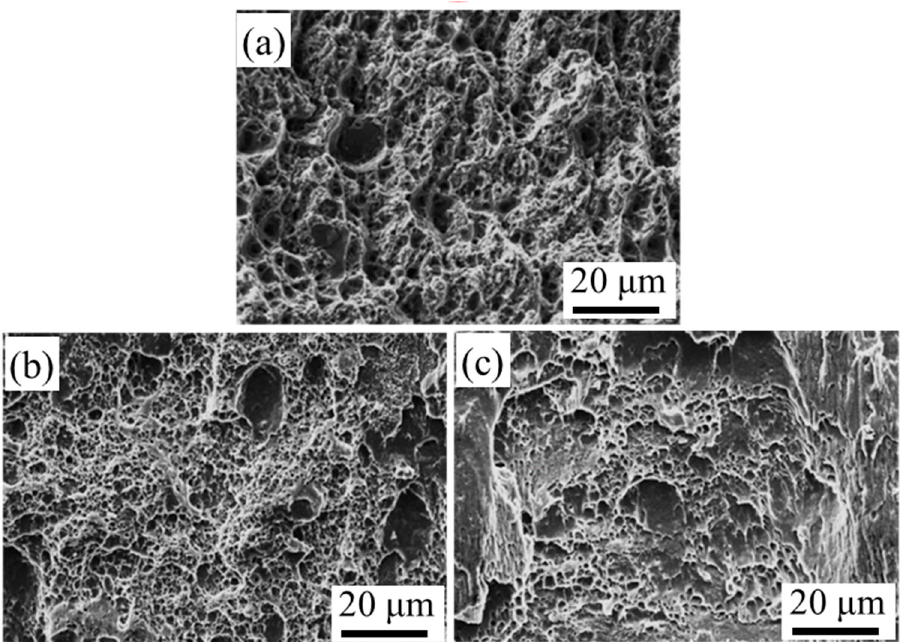
Figure 10. Scanning electron microscope (SEM) observation of tensile fracture surface: ( a ) as-welded, ( b ) PWCR–10%, and ( c ) PWCR–40% samples.